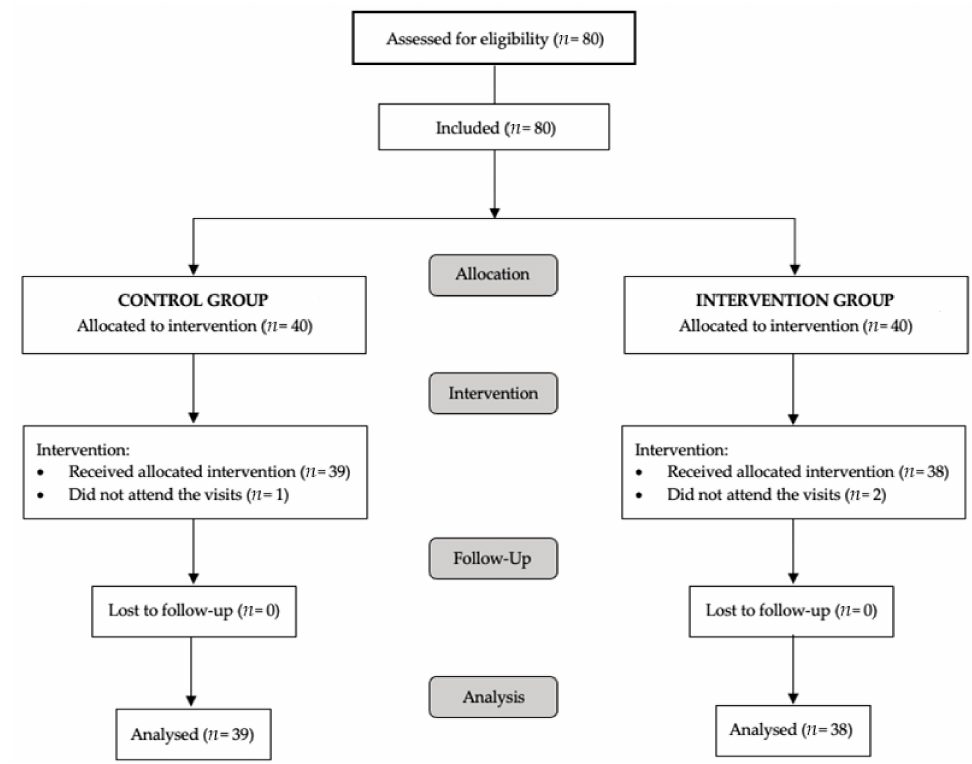
Figure 1. Flow diagram of the project: participant selection, randomization and